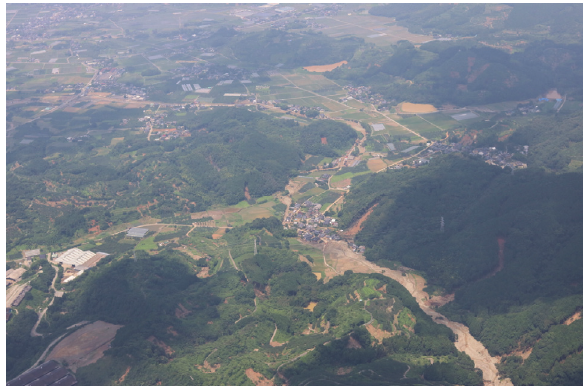
Figure 1. Sediment disasters in Asakura City